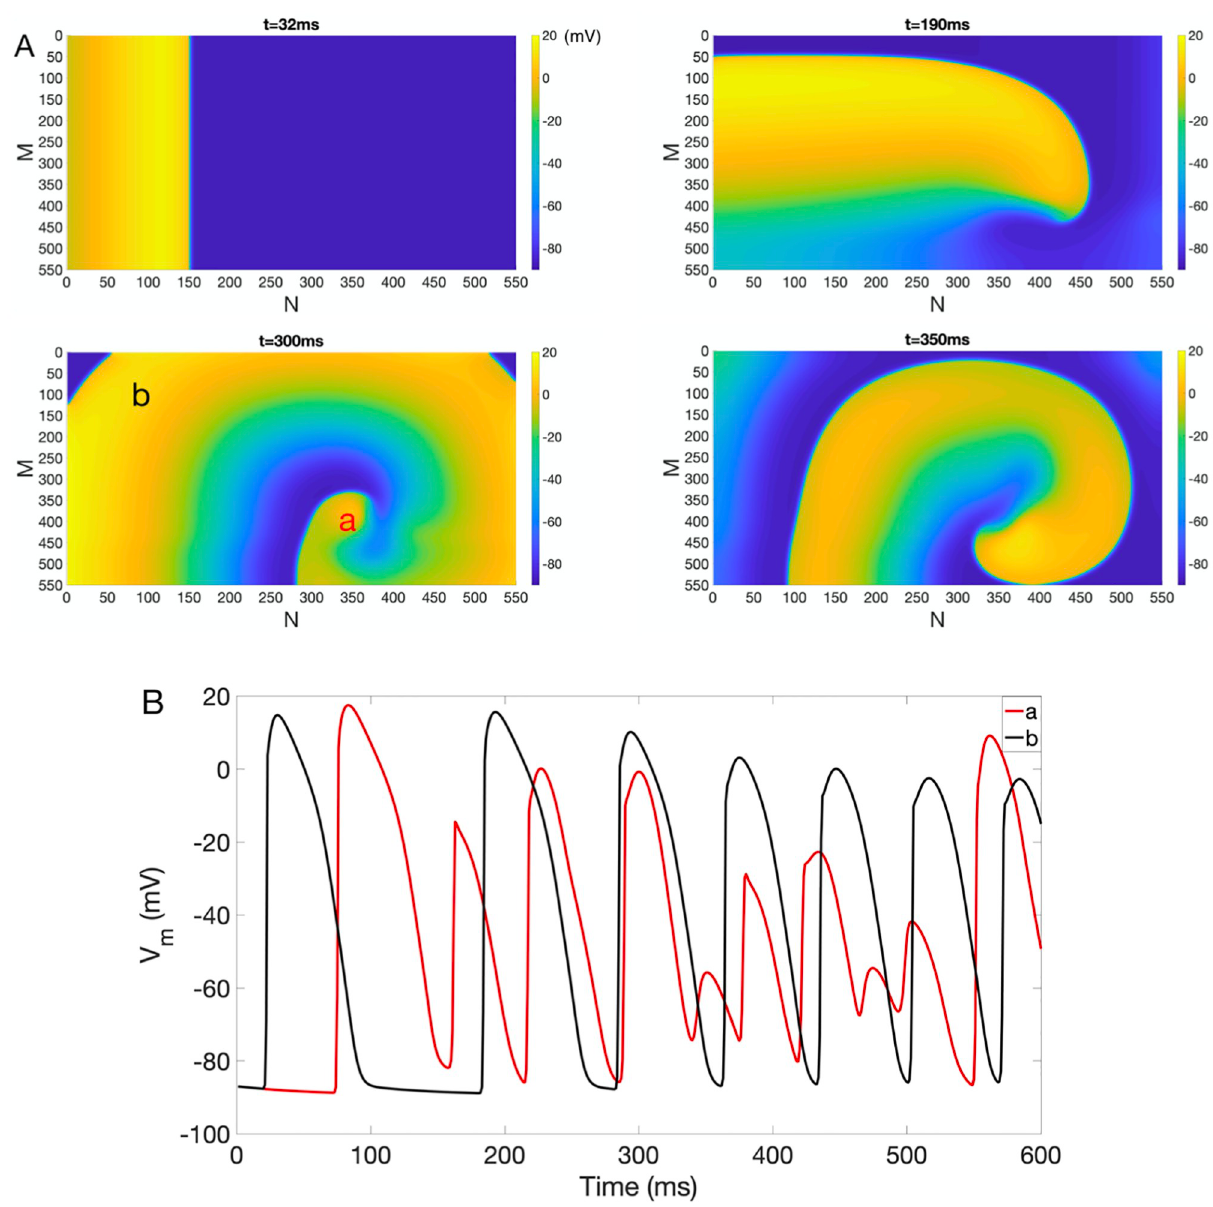
Fig 2. Reentry generated in NZ in the absence of EpC. (A) Reentry generated in 2D normal tissue consisting of 550 by 550 cells in the absence of EpC ( d cleft = 115 nm). Colorbar indicates V m (in the units of mV). Snapshots of V m at time = 32 ms, 190 ms, 300 ms and 350 ms are shown. (B) Representative V traces for points close to the core of the reentry ( a , red) and at the periphery ( b , m